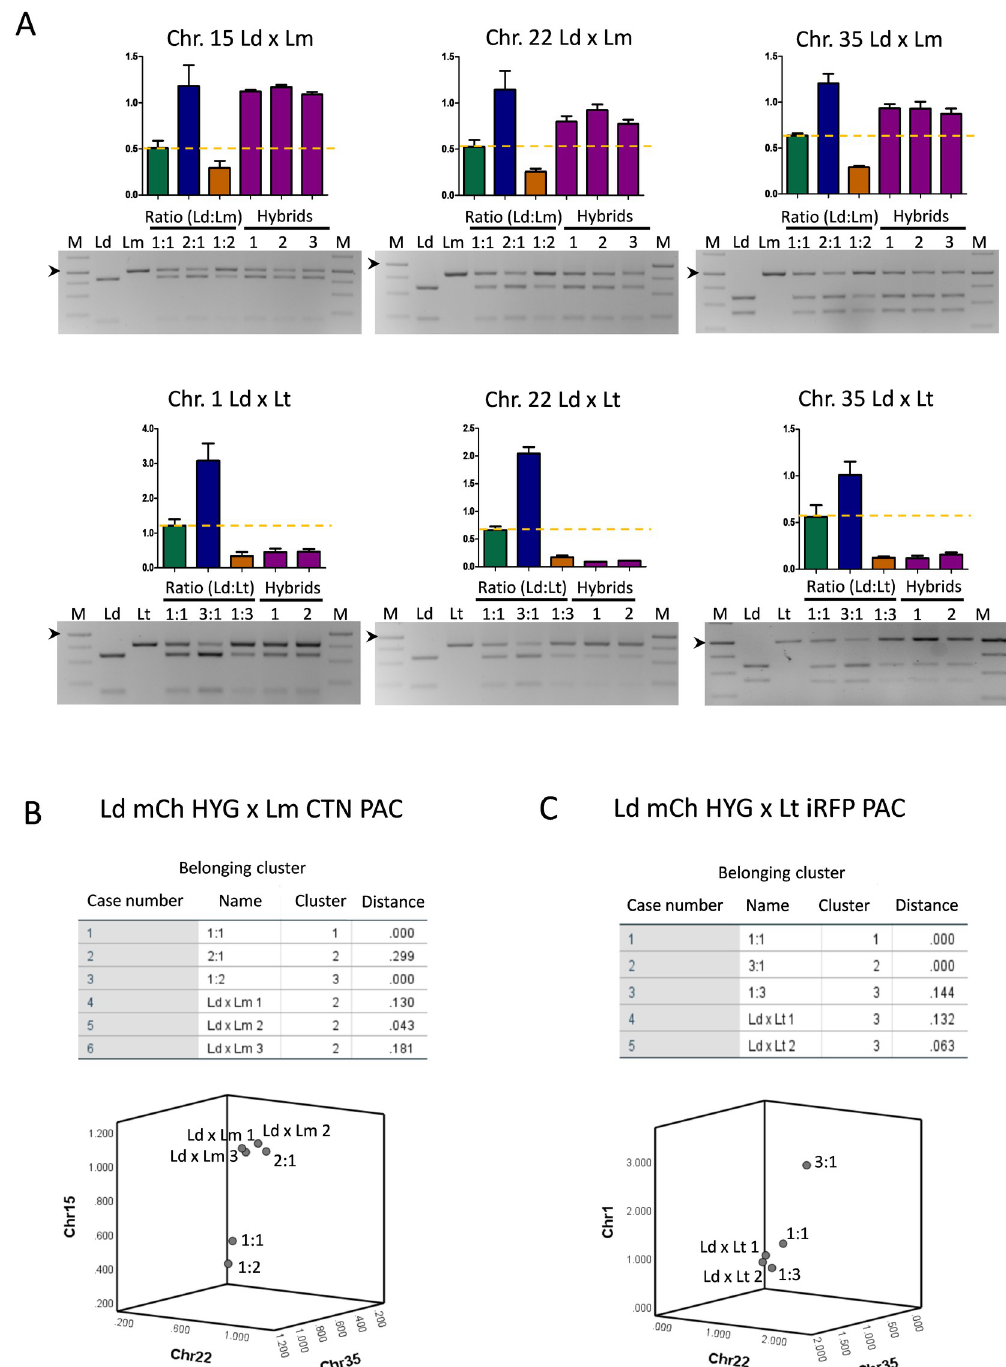
Fig 6. Characterization of the inheritance of extra chromosome sets in the interspecies hybrid clones. (A) Agarose gels of the SNP-CAPs analysis showing the DNA products after PCR amplification and enzymatic digestion of three loci present in chromosomes 2, 22 and 35. The top panel shows the electrophoretic profile of L . donovani mCh HYG (Ld), L . major CTN PAC (Lm) and three hybrids (Ld x Lm), and the ratios between the intensity of the upper band from the parental L . donovani and the uncut upper band from the other parental L . major in the corresponding hybrid clones. Simulated 3n were created by mixing parental DNA in 1:1, 1:2 and 2:1 ratio ( L . donovani : L . major ). The bottom panel shows the electrophoretic profile of L . donovani mCh HYG (Ld), L . tropica iRFP PAC (Lt) and two hybrids (Ld x Lt), and the ratios between the intensity of the upper band from the parental L . donovani and the uncut upper band from the other parental L . tropica in the